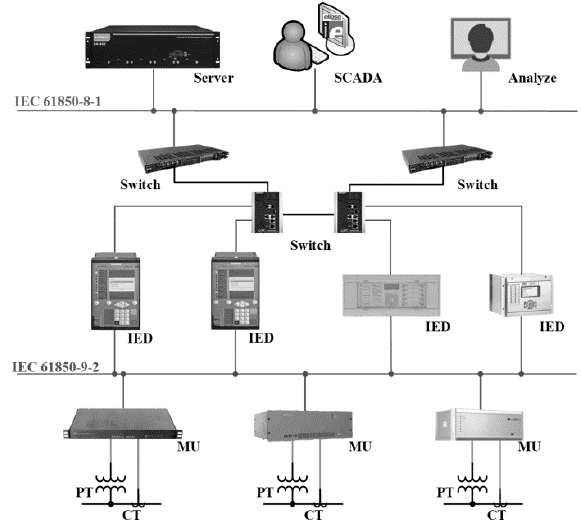
Figure 2. The example configuration of the proposed intelligent substation SCADA system.